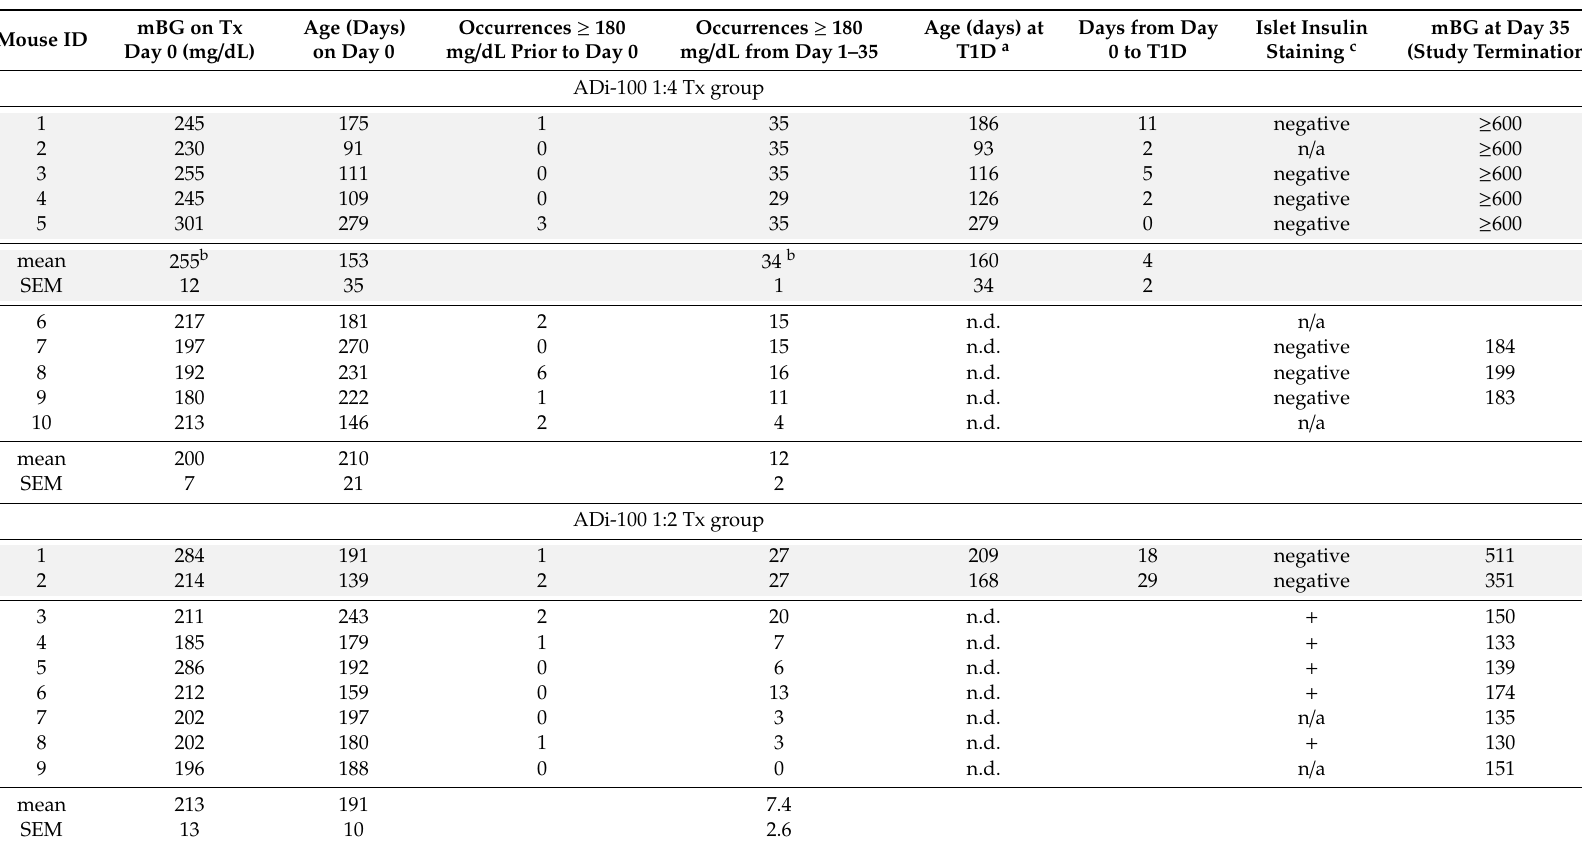
Table 1. mBG analysis of ADi-100-treated NOD female mice that showed very high hyperglycemia on the first day of treatment (day